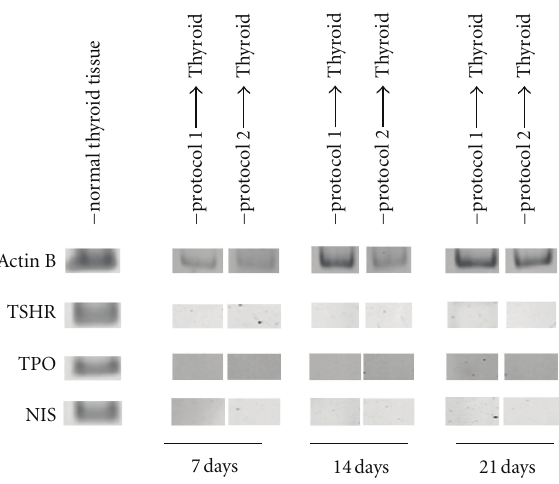
Figure 5: PCR results for thyroid markers expression in derived cells under di ff erent protocols and normal human thyroid